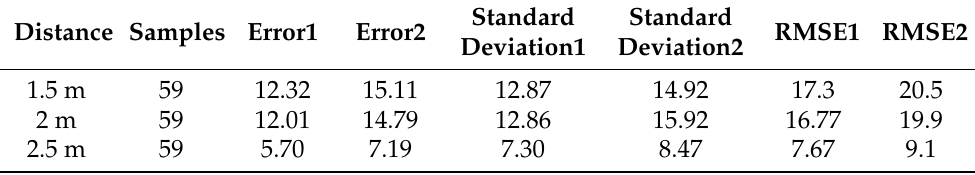
Table 4. Measured